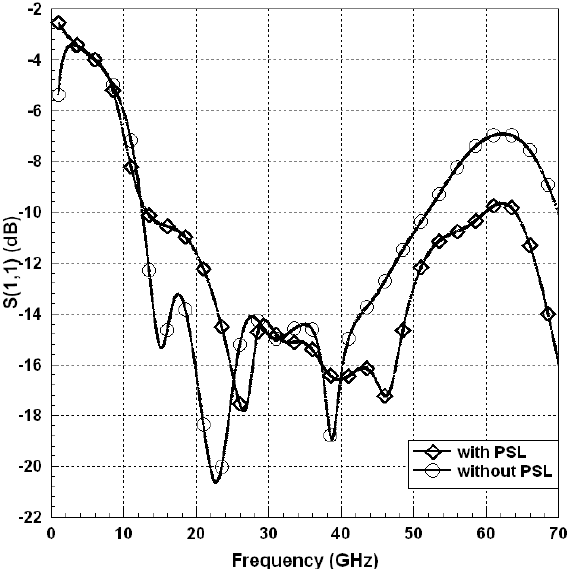
Figure 15. Comparison of PSL with and without PSL.